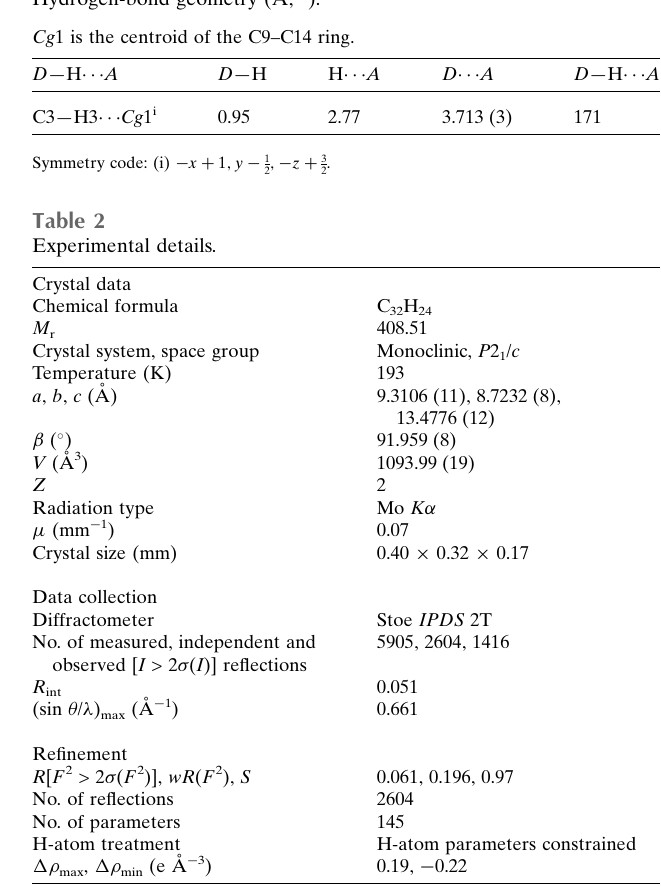
Table 1 Hydrogen-bond geometry (A˚ , (cid:3) ).